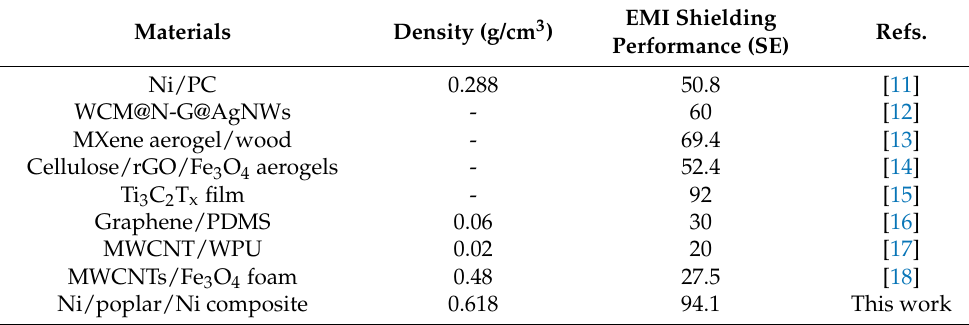
Table 1. Performance summary of some electromagnetic shielding